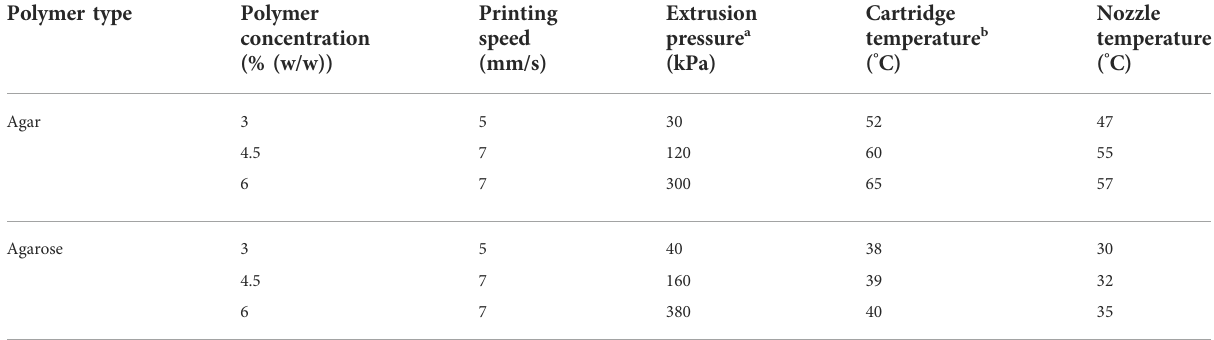
TABLE 1 Printing parameters employed in the fabrication of activity assay cylinders and exemplary prints made from inks based on low-melt agarose and agar. Polymer